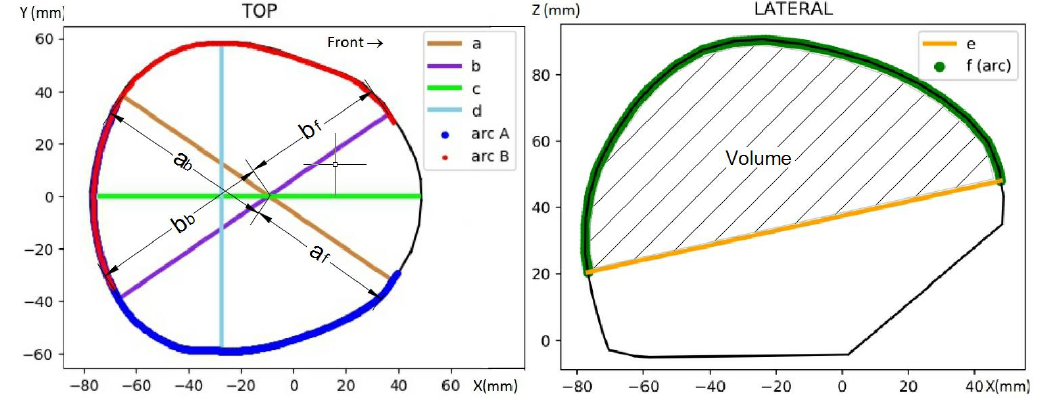
Figure 3. ( Left ): Measurements for computing asymmetry and cephalic indices. ( Right ): Measure- ments for computing the towering index.